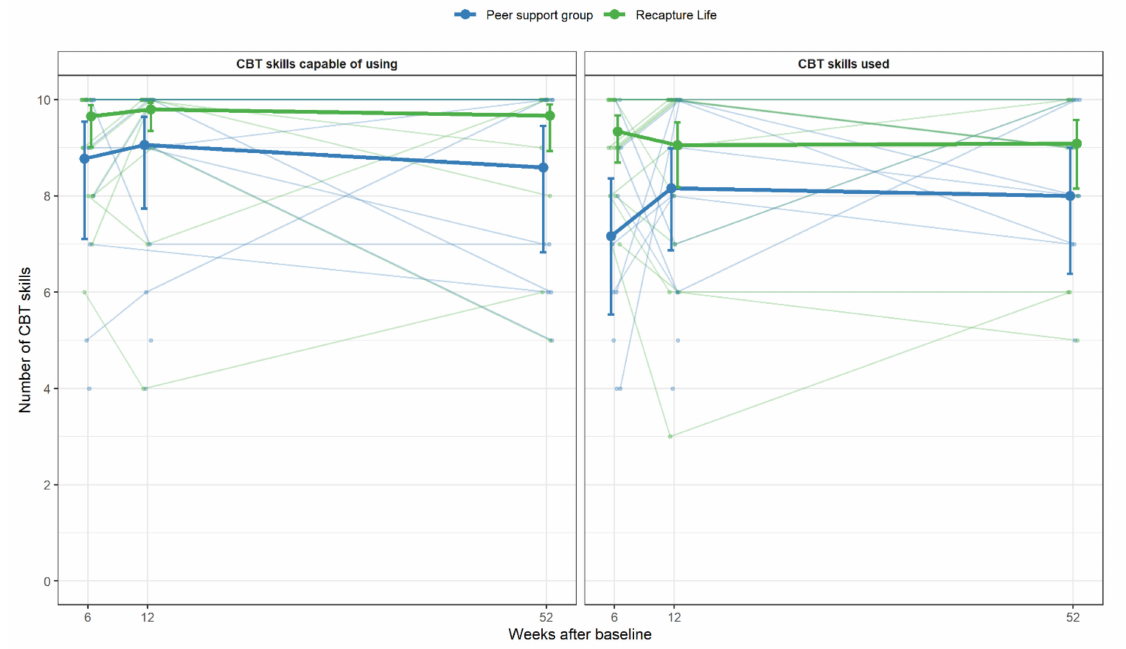
Figure 5. Cognitive-behavioral therapy skills confidence and use, by treatment arm. Note. Individual scores are displayed, overlaid with thicker lines showing group-specific means and 95% confidence